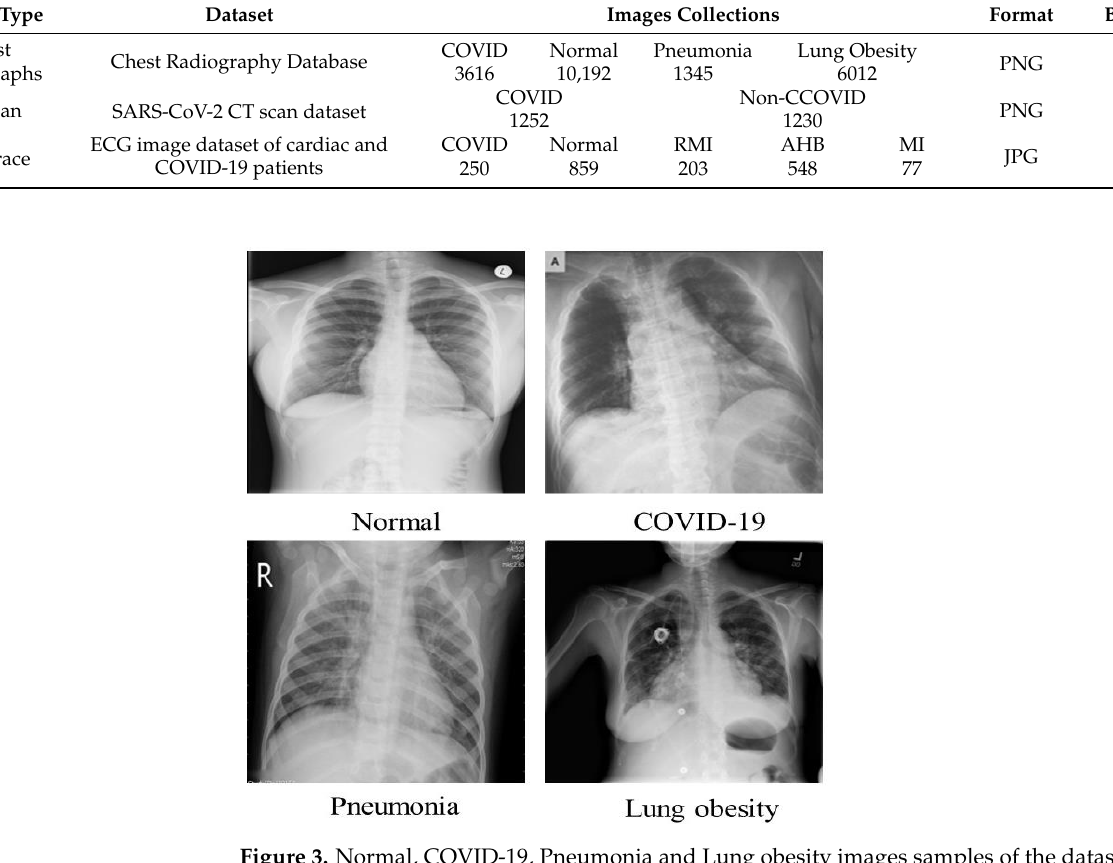
Figure 3. Normal, COVID-19, Pneumonia and Lung obesity images samples of the dataset.